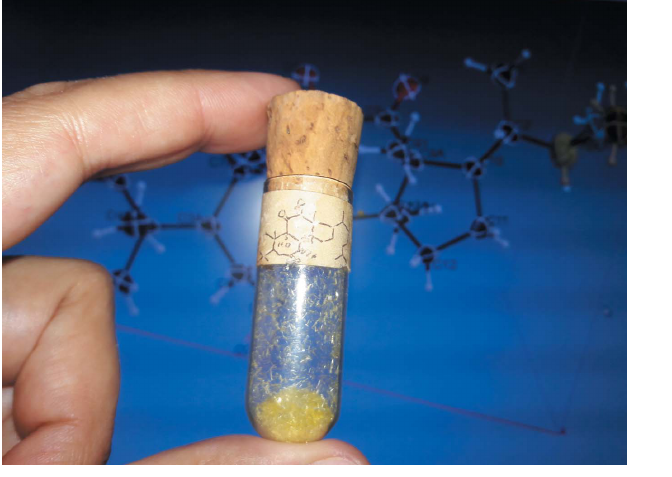
Figure 1 Crystals of the title compound in the original tube where they were saved for more than 60 years.